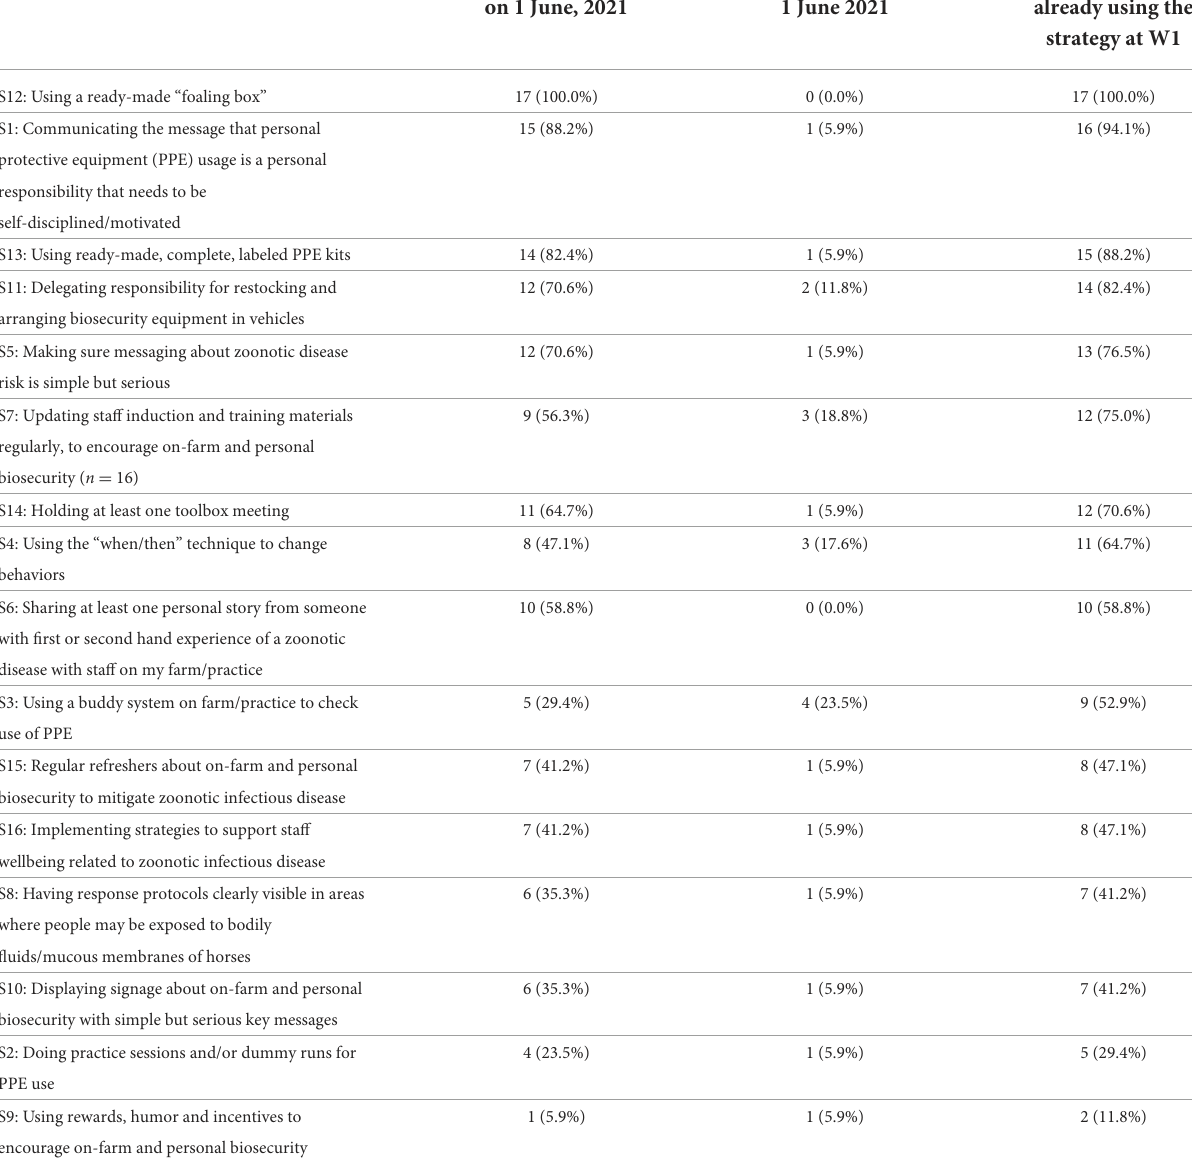
Started doing this Total number of before workshop after workshop on participants on 1 June, 2021 1 June 2021 already using the strategy at